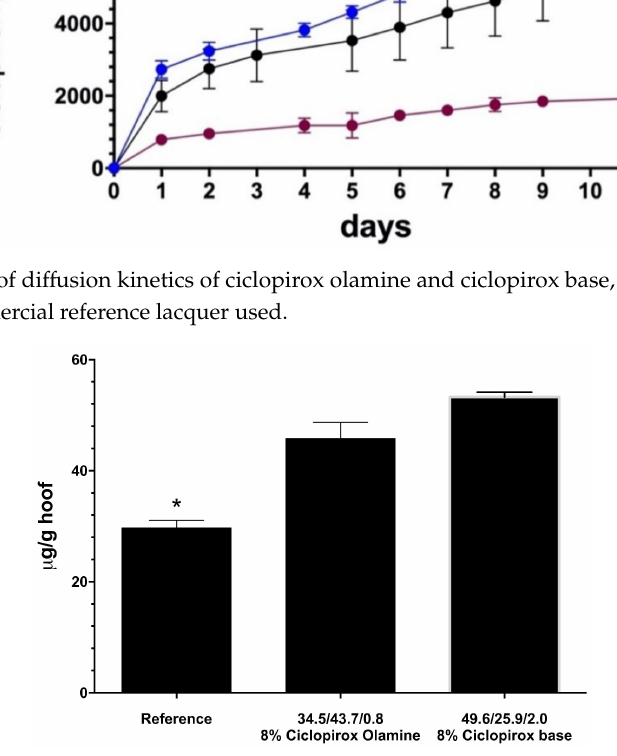
Figure 7. Amount of ciclopirox base found in hooves after 11 days of the di ff usion experiment. *Significant di ff erences between means for an α <